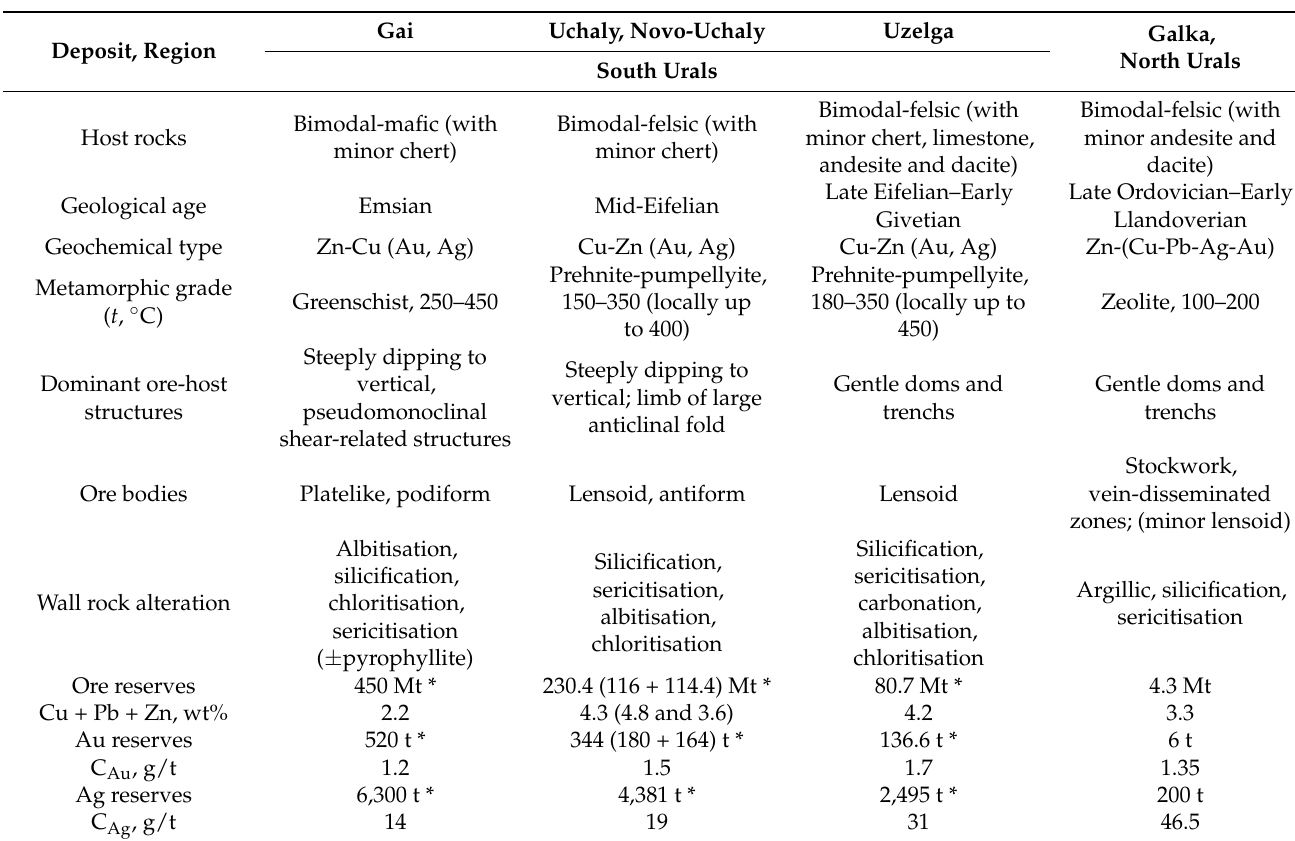
Table 5. Characteristics of the studied VMS